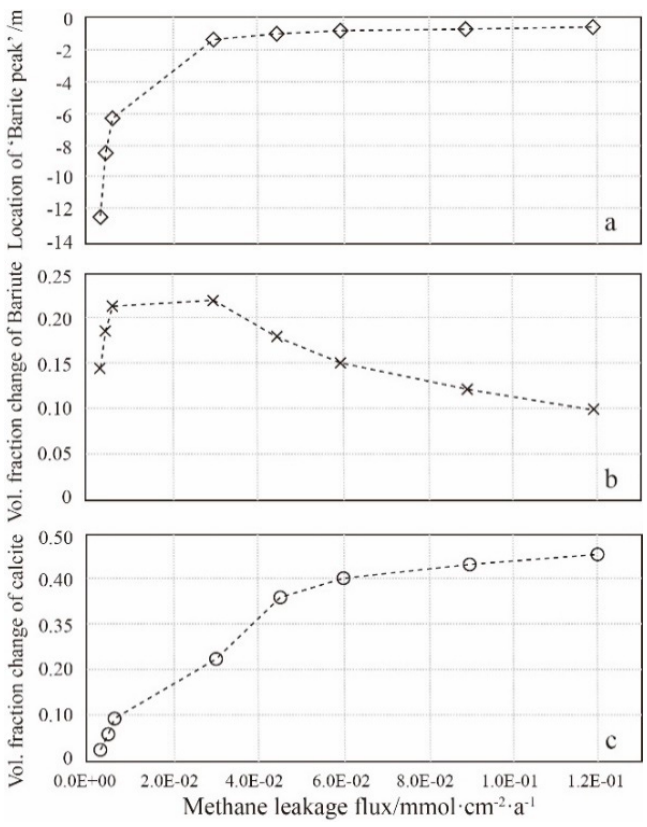
Figure 6. Relationship between methane leakage flux and authigenic minerals. ( a ) Location of Barite front with flux. ( b ) Volume fraction change of barite. ( c ) Volume fraction change of calcite.